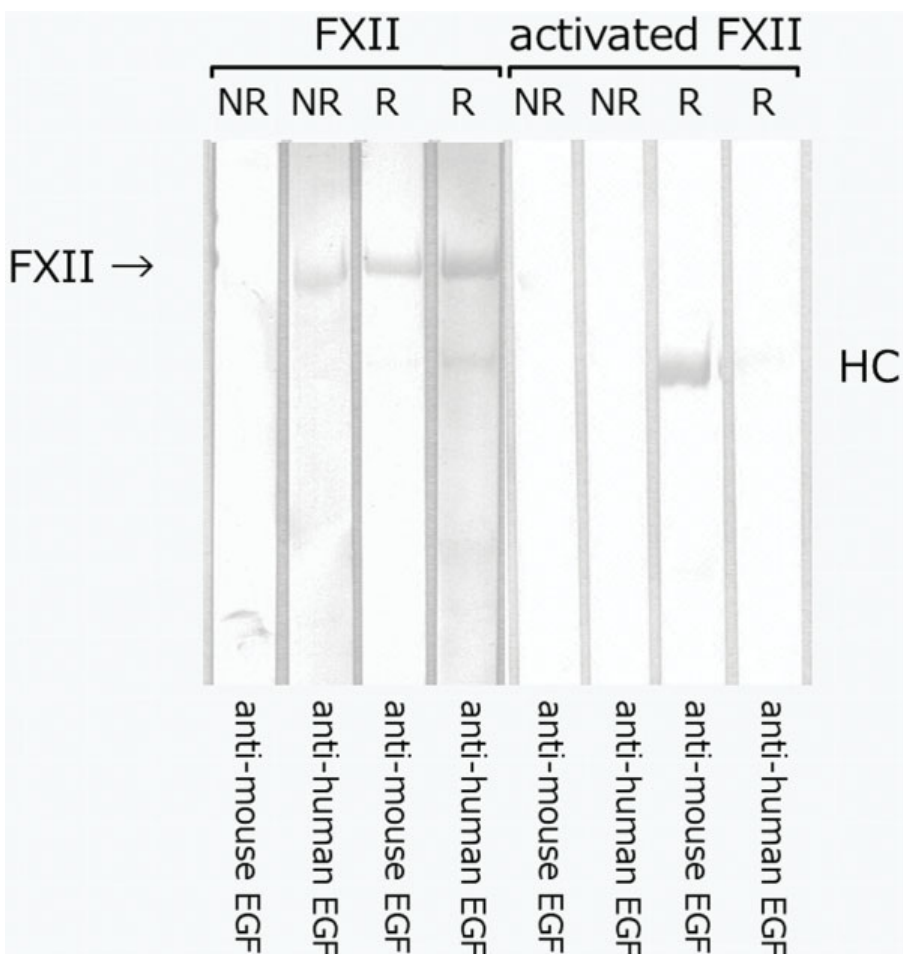
Fig. 7. A representative experiment showing binding of polyclonal antibodies to EGF through FXII. FXII or activated FXII was subjected to SDS- PAGE under nonreducing (NR) or reducing (R) conditions. In reduced forms, activated FXII was divided into heavy chain and light chain. FXII or activated FXII (8 µL of 100 µg/mL solution) was applied to each lane. Subsequent transfer to PVDF membranes was performed for 20 minutes at 0.1 amps. Membranes were then blocked for 2 hours with 1% BSA in TBS, pH 7.3. After incubation with polyclonal antibodies to recombinant human EGF (antihuman EGF; 0.2 µg/mL) or mouse EGF (antimouse EGF; 0.2 µg/mL) for 2 hours, we performed three washes in 0.05% Tween 20/ TBS. The membranes were then exposed to horseradish peroxidase-conjugated polyclonal antibodies to goat IgG for 1 hour, followed by washing as described above. The immunoreactive bands were developed using 3,3 ′ ,5,5 ′ -tetramethylbenzidine. BSA, bovine serum albumin; EGF, epidermal growth factor; FXII, factor XII; HC: heavy chain; IgG, immunoglobulin G; PVDF, polyvinylidene di fl uoride; SDS-PAGE, sodium dodecyl sulfatepolyacrylamide gel electrophoresis; TBS, Tris-buffered